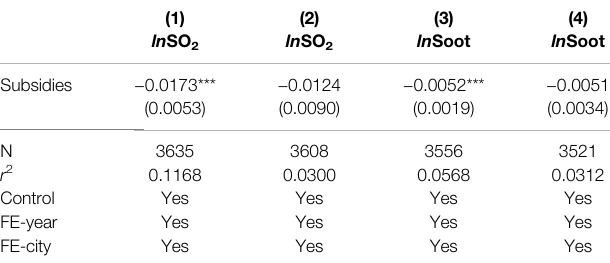
TABLE 8 | Heterogeneity of low discretion slack (SR1).